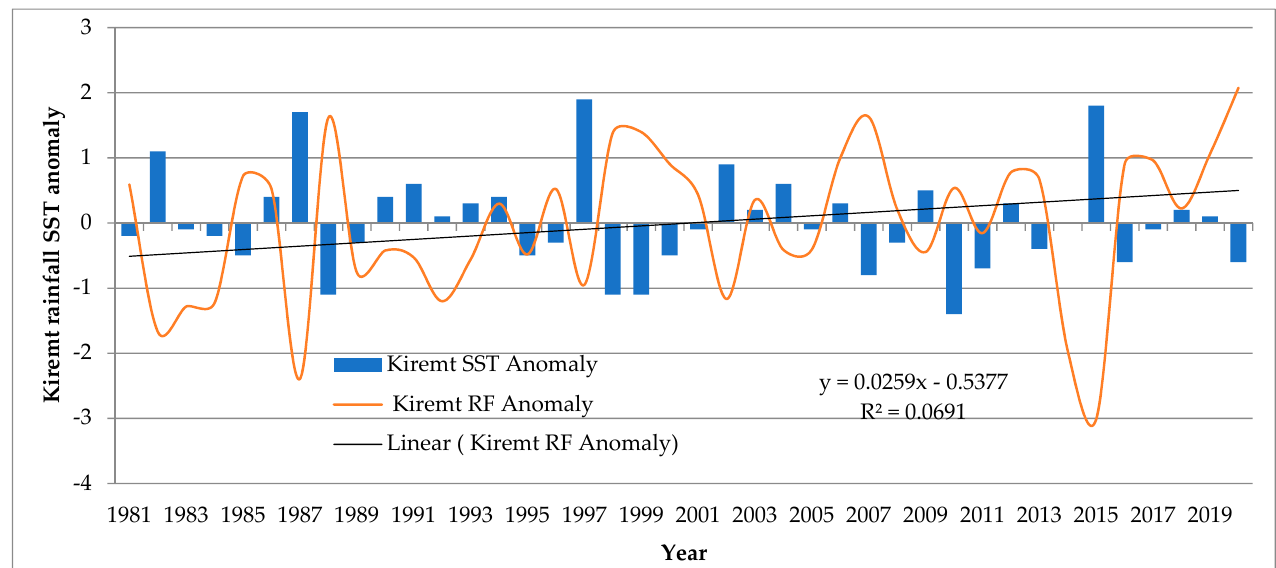
Figure 9. Jemma Kiremt season rainfall anomaly with Kiremt SST anomaly using nino 3.4.